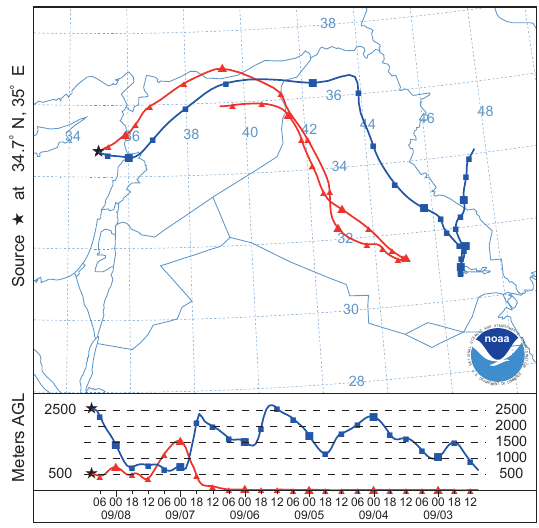
Figure 3. Six–day HYSPLIT backward trajectories arriving in the Cyprus region at 35 ◦ E (about 160km east of the Limassol lidar station) at 500m (red, lower dust layer) and 2500m height (blue, upper dust layer) on 8 September 2015, 09:00UTC